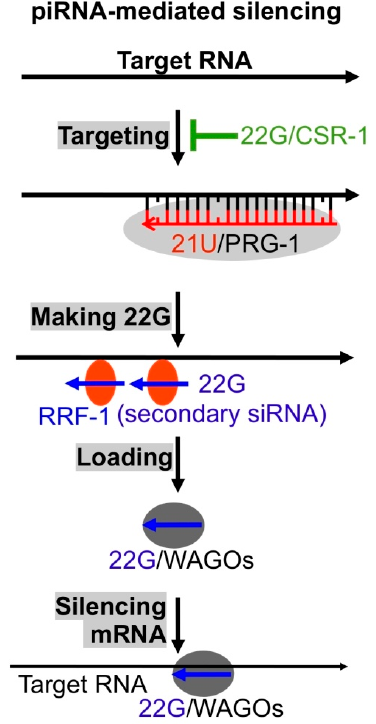
Figure 4. The antivirus sensor piRNA. C. elegans 21U-RNA (21U, piRNA) / Argonaute Piwi related gene 1 (PRG-1) complex binds target RNAs with up to 3 mismatches, RdRP RRF-1 is recruited to generate secondary siRNAs (22Gs) using target RNAs as templates, 22Gs are loaded to WAGOs to form secondary RISCs, and these RISCs directly silence target RNAs.